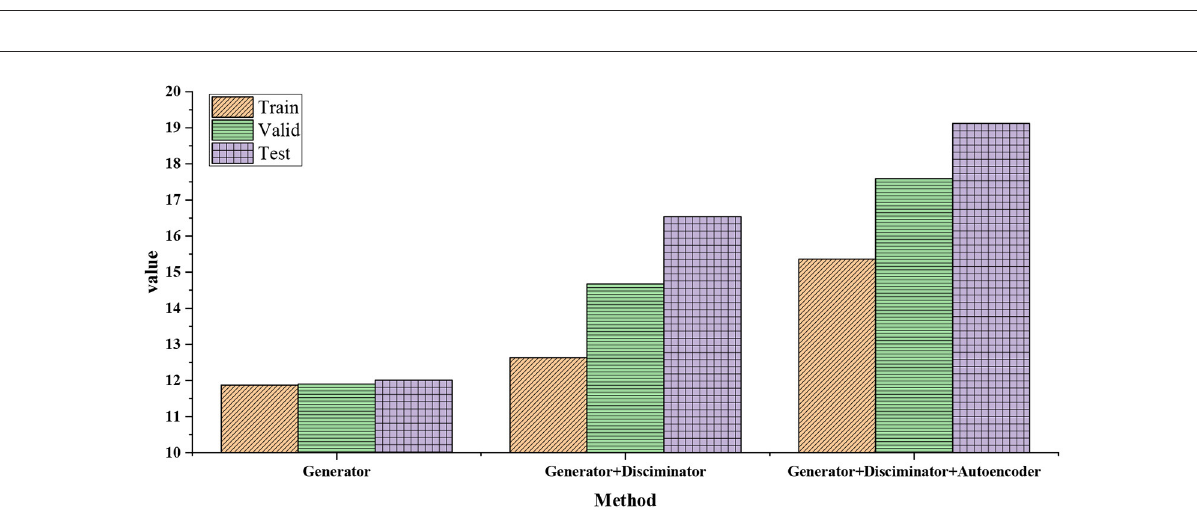
FIGURE7 Influence of different data processing methods on final loss function in audio feature extraction stage.